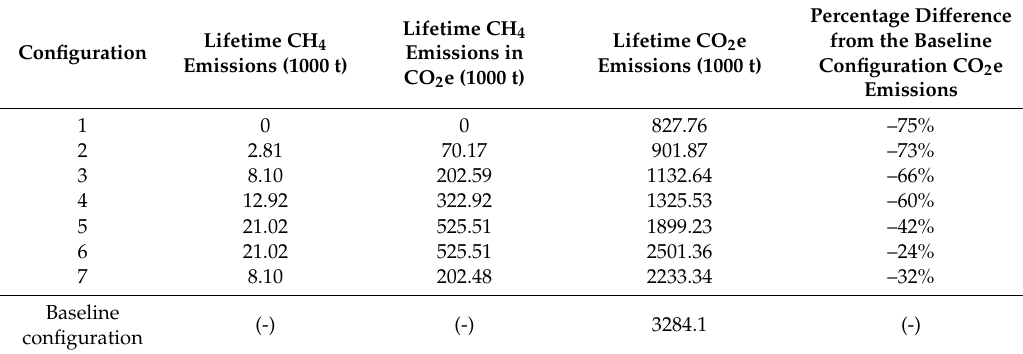
Table 16. Lifetime equivalent CO 2 emissions for the cruise ship power plant solutions.